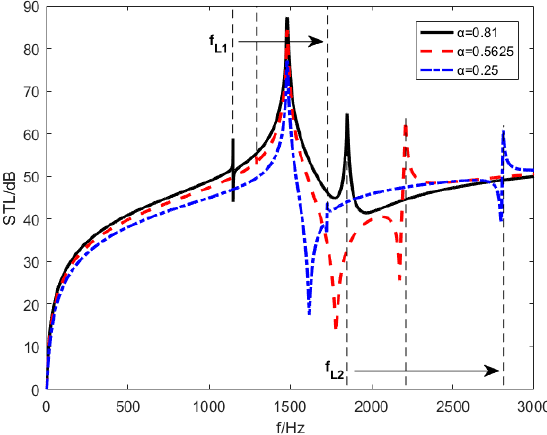
Figure 18. STL curves under different piezoelectric sheet area ratios.